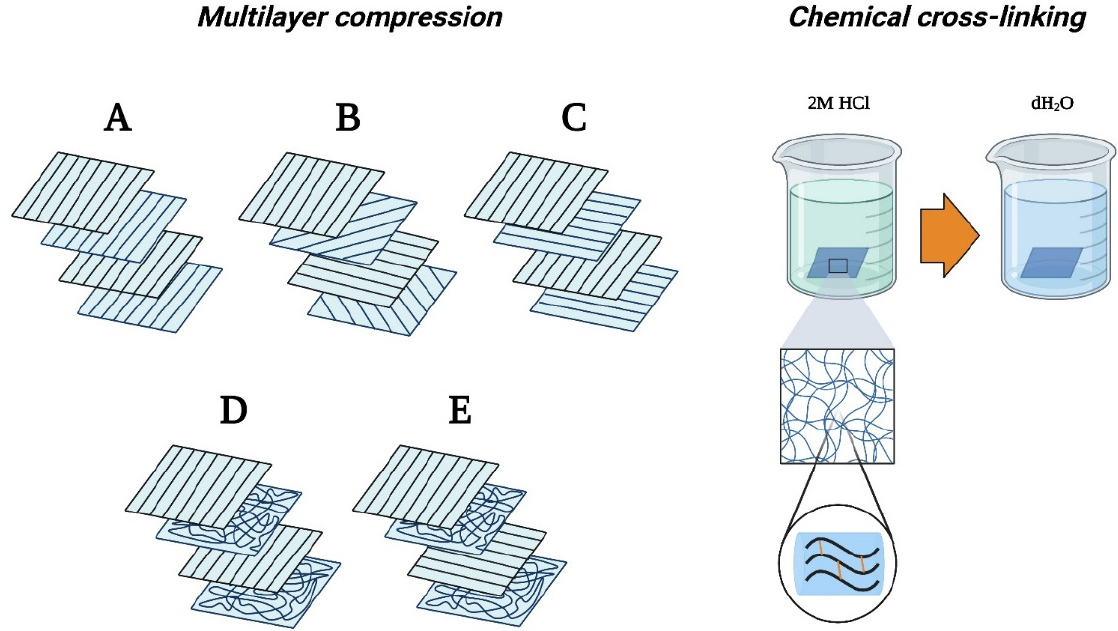
Figure 2. Multilayer compression configurations and cross-linking method. Note: Multilayer Config- urations: ( A ) 4 × 0 ◦ , ( B ) 0 ◦ +45 ◦ +90 ◦ + 125 ◦ , ( C ) 0 ◦ +90 ◦ +0 ◦ +90 ◦ , ( D ) 2 × 0 ◦ +non-oriented layer ( E ) 0 ◦ + non-oriented layer +90 ◦ + non-oriented layer.